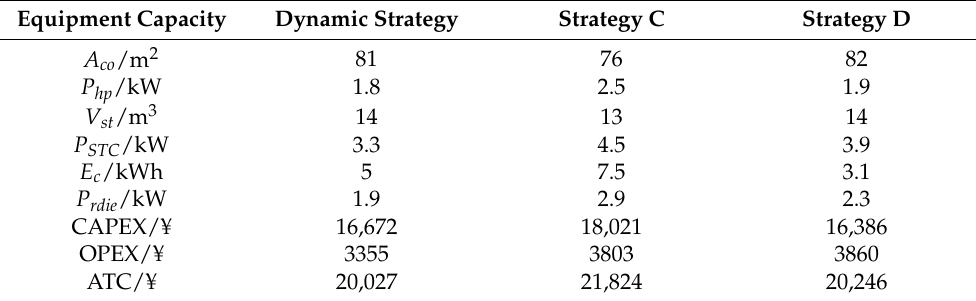
Table 7. Optimized equipment capacities and system